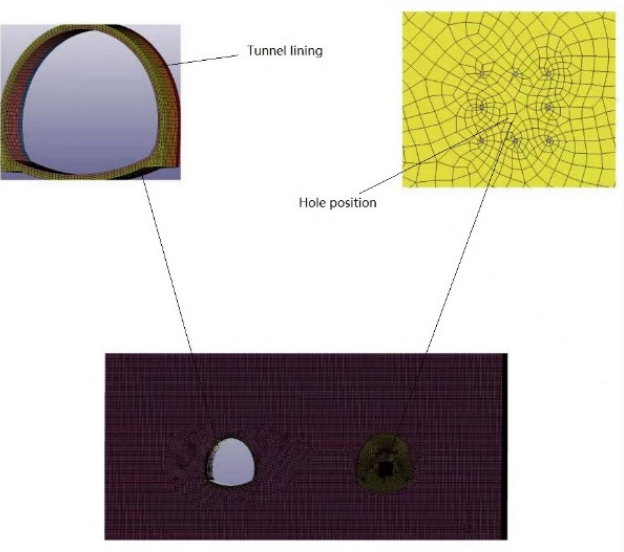
Figure 2. Three-dimensional finite element model.